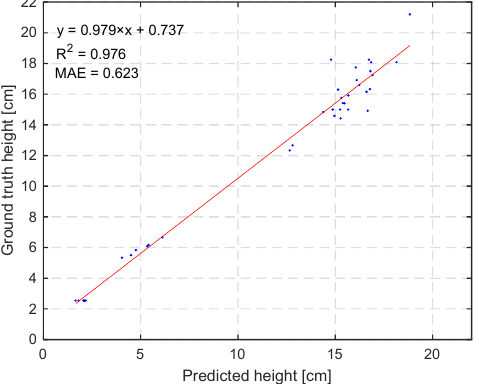
Figure 15. Correlation of manually measured ground truth height (ground truth height) of lettuces during destructive measurements compared with predicted height (predicted height) from RealSense camera images of lettuces.